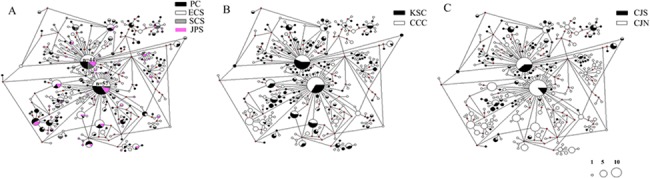
Network of Thais clavigera using COI data.The size of circles is proportional to haplotype frequency and median vectors are indicated with a red pie chart. The different shadings of the haplotypes refer to the respective locations in terms of the three population groupings: (a) potential refuges (PC, Pacific Ocean; ECS, East China Sea; SCS, South China Sea; ES, East Sea [SJ, Sea of Japan]); (b) ocean currents (KSC, Kruoshio Current with the branch currents; CCC, China Coastal Current and Subei Coastal Current); (c) Changjiang River (CJS, the South of Changjiang River; CJN, the North of Changjiang River).